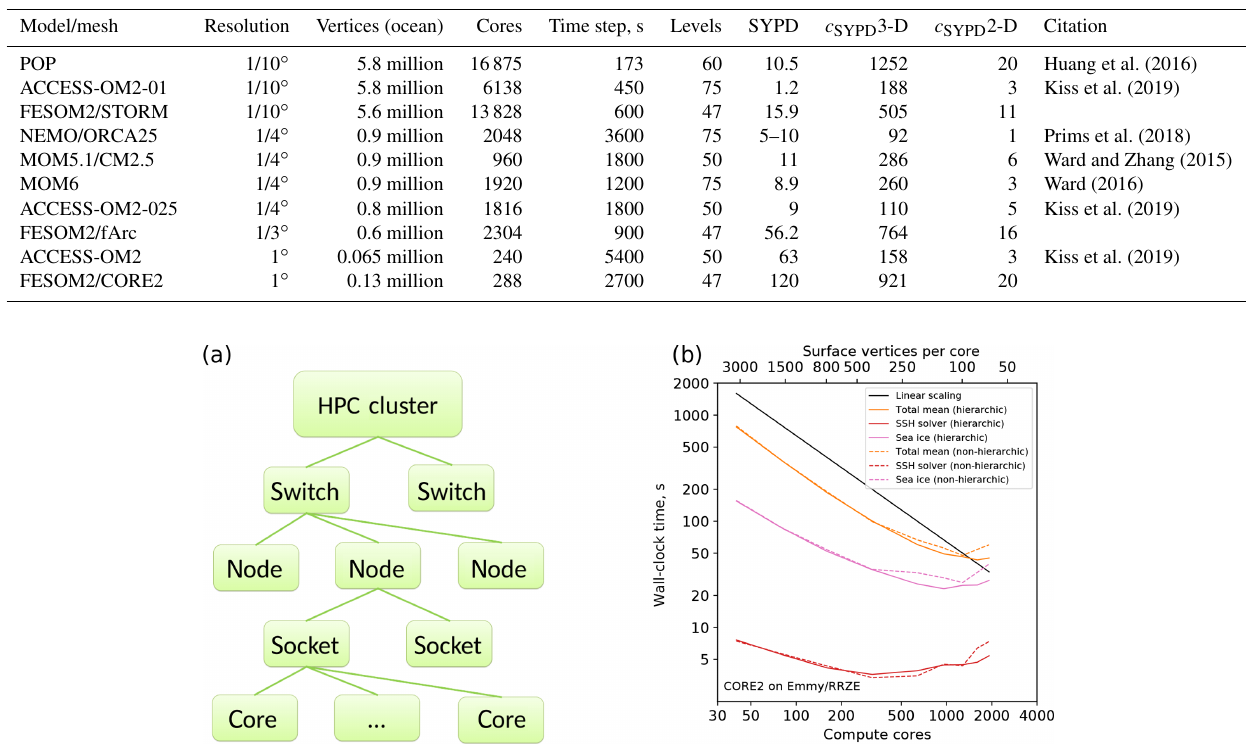
Figure 11. Schematics of an HPC cluster for purposes of hierarchic mesh partitioning (a) and a comparison of the total, SSH, and sea-ice scaling for hierarchic (continuous lines) and nonhierarchic (dashed lines) partitionings for the CORE2 mesh on Emmy (RRZE, Erlangen, b